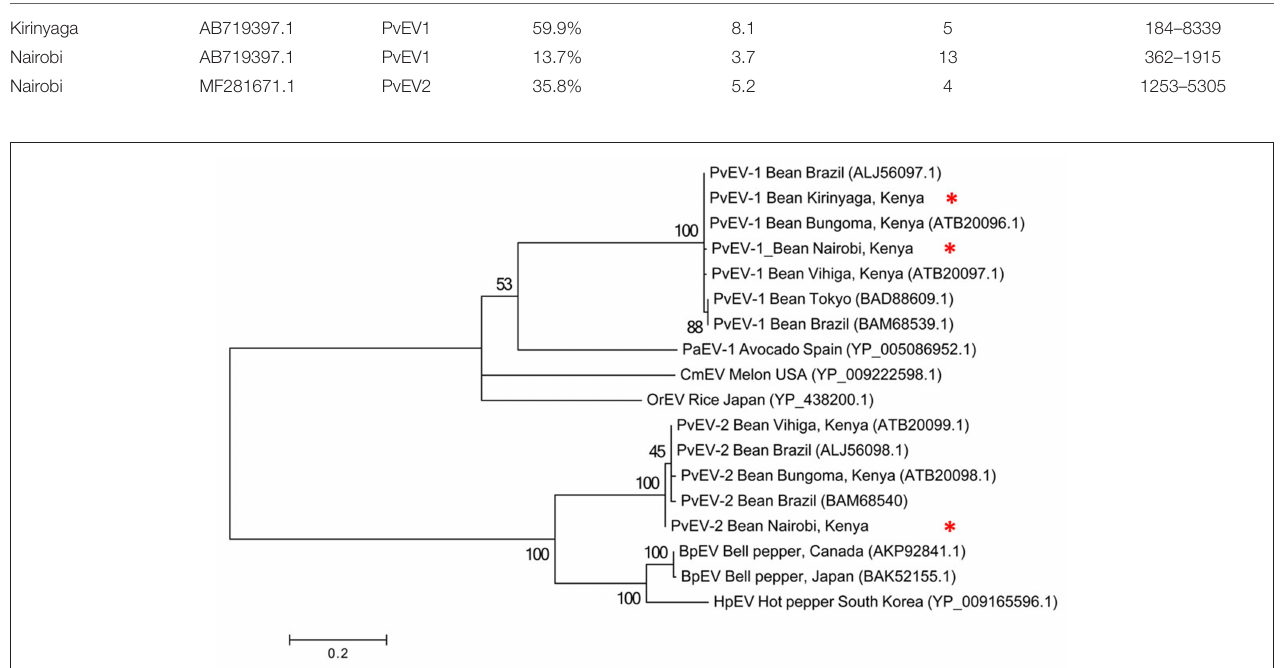
TABLE 6 | The coverage and average read depth of Phaseolus vulgaris Endornavirus (PvEV) 1 and 2 before sample pooling. Sample pool